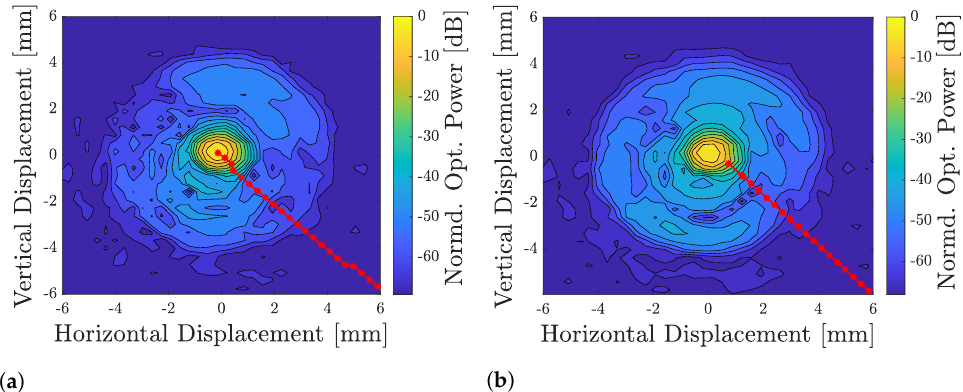
Figure 11. QD-based alignment trajectory. ( a ) Tx collimator alignment. ( b ) Rx collimator